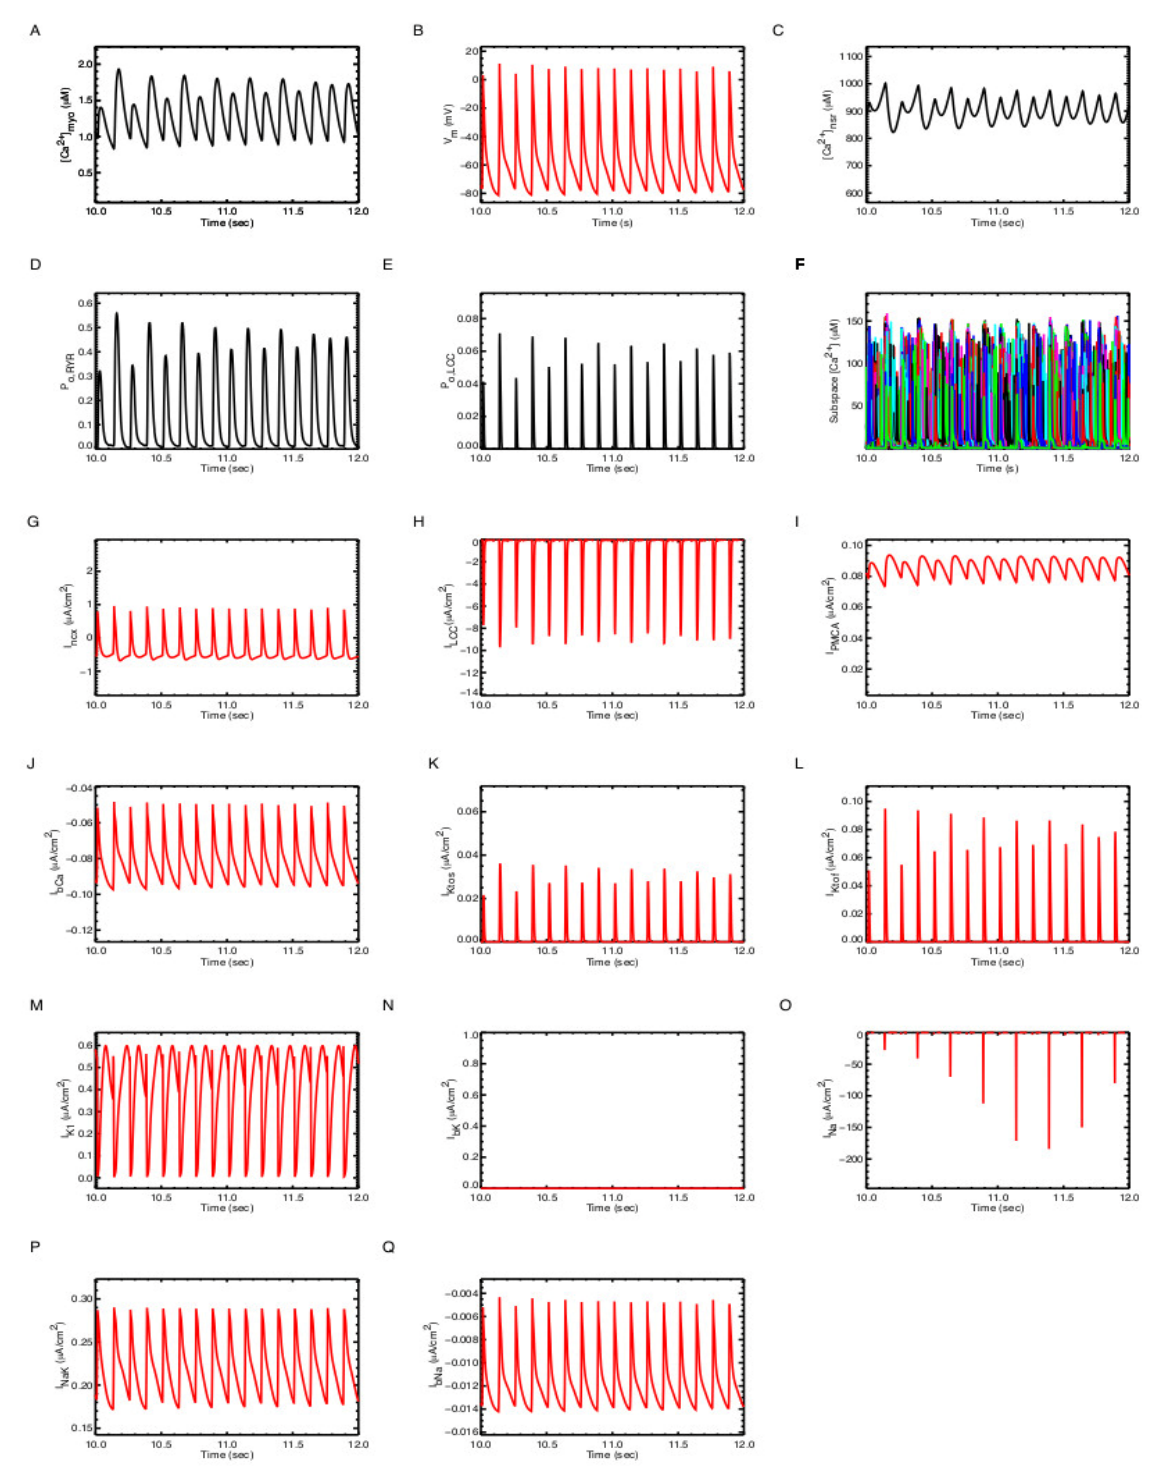
Figure A5. Pacing at 8 Hz pacing produces alternans with diastolic [Na + ]I = 20 mM. To emulate the excitation-contraction of the cell, a stimulus current I stim = − 6.5189 µ A/cm 2 was given during 5.0 ms second [40]. ( A ) [Ca 2+ ] myo ; ( B ) Membrane potential (V m ); ( C ) Network SR Ca 2+ concentration ([Ca 2+ ] nsr ); ( D ) RyR2 open probability (P O ,RyR); ( E ) L-type Ca 2+ channel open probability (P O ,LCC); ( F )subspace free Ca 2+ concentration ([Ca 2+ ] ds ); ( G ) L-type Ca 2+ current (I LCC ); ( H ) NCX current (I ncx ); ( I ) PMCA current (I PMCA ); ( J ) Ca 2+ current (I Na ); ( K ) Na/K exchanger current; ( L ) K1 current; ( M ) slow component of transient-outward K + current; ( N ) fast-component of transient-outward K + current; ( O ) Na + current; ( P ) Na + -K + ATPase current; ( Q ) Background Na + current.